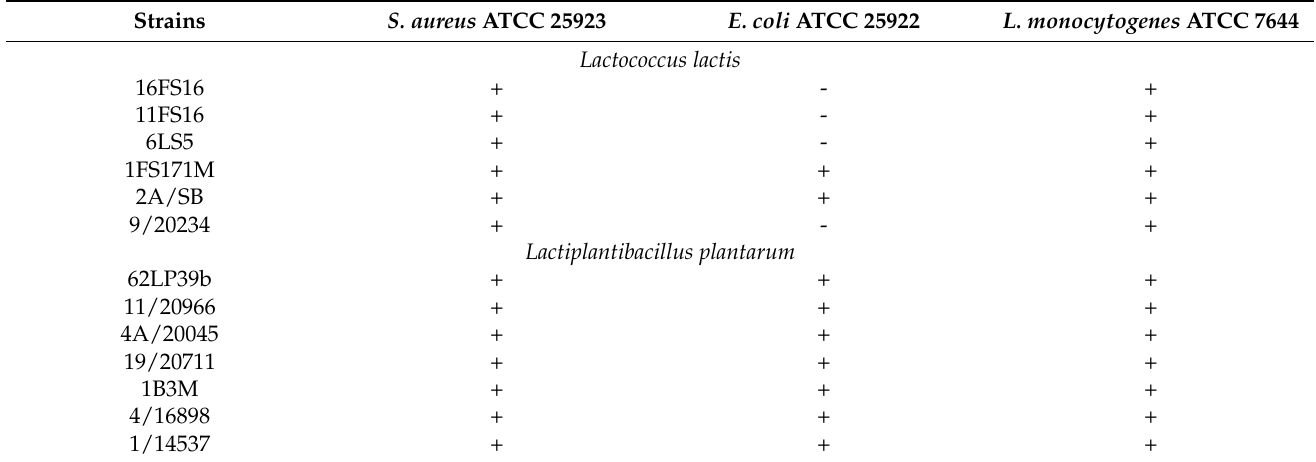
Table 2. Antibacterial activity of autochthonous strains determined by the agar spot